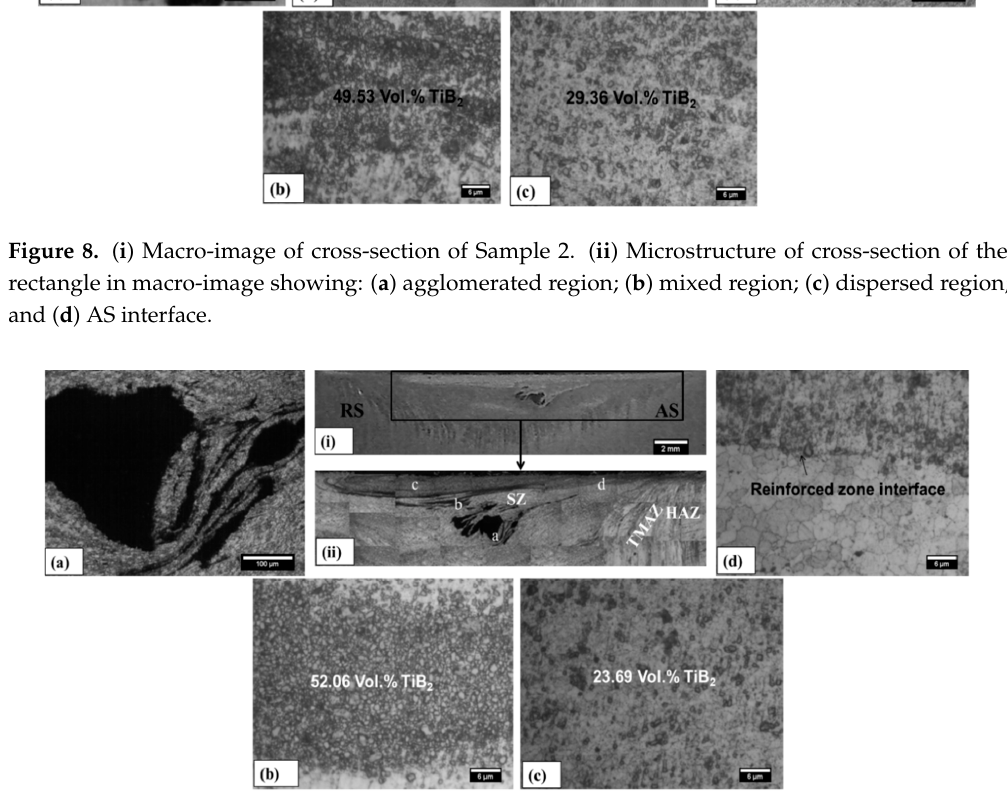
Figure 9. ( i ) Macro-image of cross-section of Sample 3. ( ii ) Microstructure of cross-section of the rectangle in macro-image showing: ( a ) agglomerated region; ( b ) partially mixed region; ( c ) dispersed region; and ( d ) reinforced zone interface.